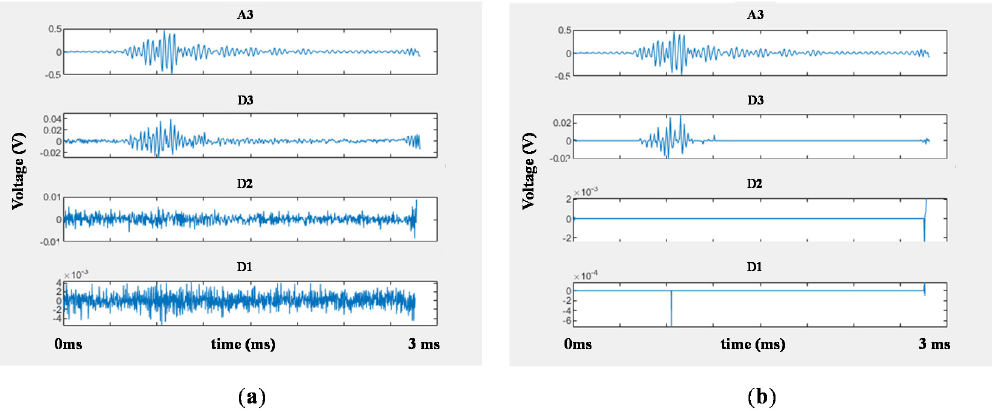
Figure 11. The decomposed signals from 9 J impact, with R of 4 mm: ( a ) the signal before denoising and ( b ) the signal denoised using soft thresholding.